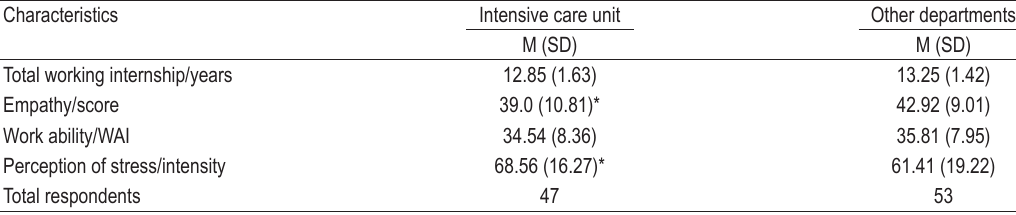
TABLE 2. Descriptive values of job characteristics by the department of workplace Characteristics